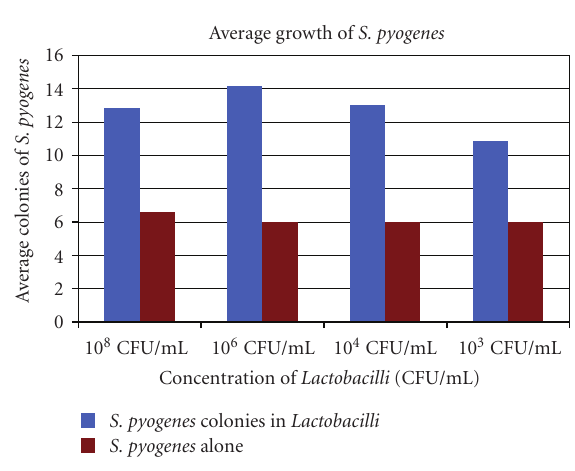
Figure 2: Average growth of S. pyogenes , suggesting that Lactobacilli may assist the growth of S.